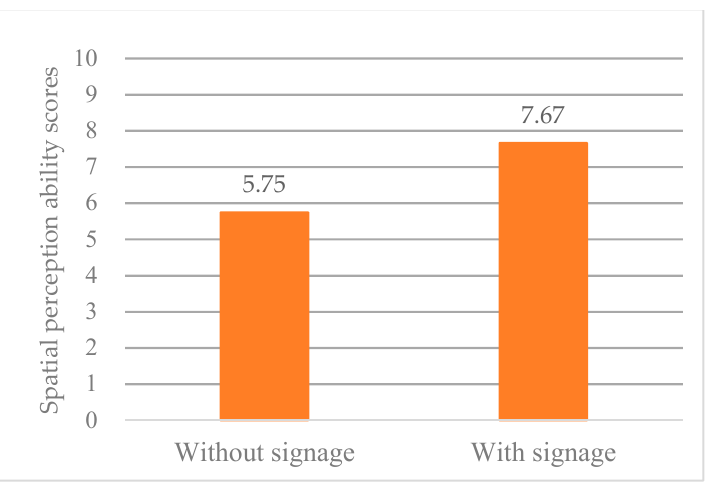
Figure 7. Spatial perception ability scores of groups without and with signage.